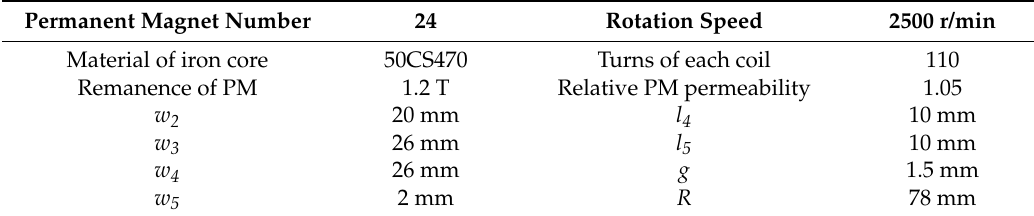
Figure 10. TFPMDGs with different iron cores: ( a ) Wider “I” shape rotor iron core; ( b ) “T” shape rotor iron core; ( c ) Five-stair-step shape rotor iron core; ( d ) The radius of the design. Table 2. Dimension parameters of different shapes of iron